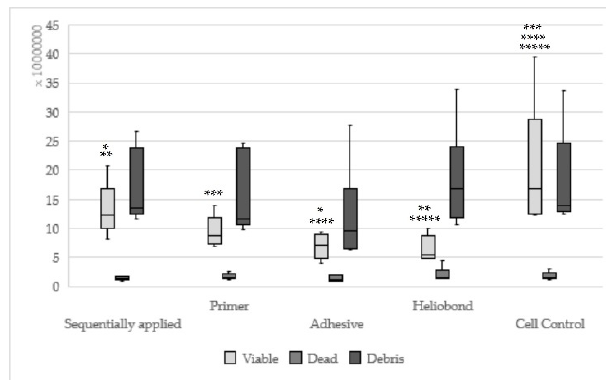
significant differnces in the corresponding groups).